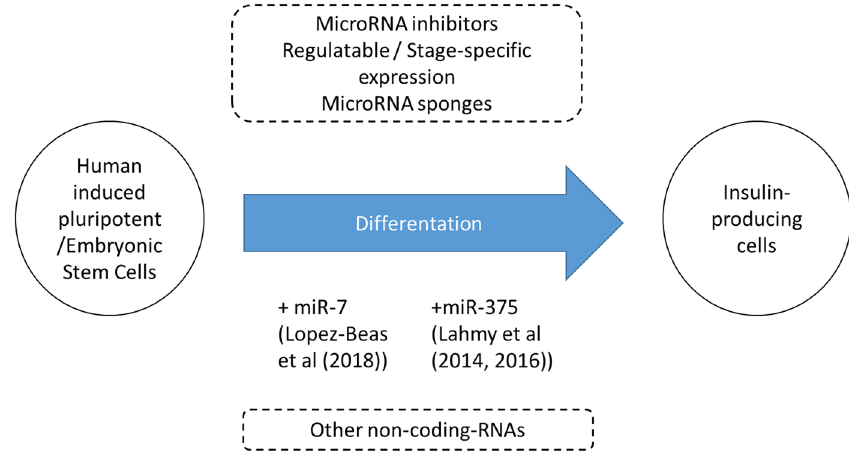
Figure 1: This commentary describes distinct studies ( by Lopez - Beas et al and Lahmy et al ) that used miR - 7 and miR - 375 for directed di ff erentiation of stem cells into insulin - producing cells respectively. While innovative, other approaches ( in dashed boxes ) such as miR inhibitors or other noncoding RNAs can also be used in the future to enhance the β - cell di ff erentiation